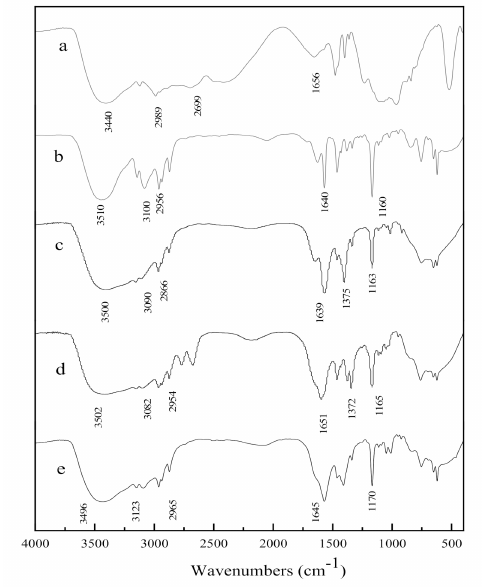
Figure 2. FT-IR spectra of ChOH ( a ), [Bmim]Br ( b ), [Bmim][HCOO] ( c ), [Bmim][CH 3 COO] ( d ) and [Bmim]OH ( e